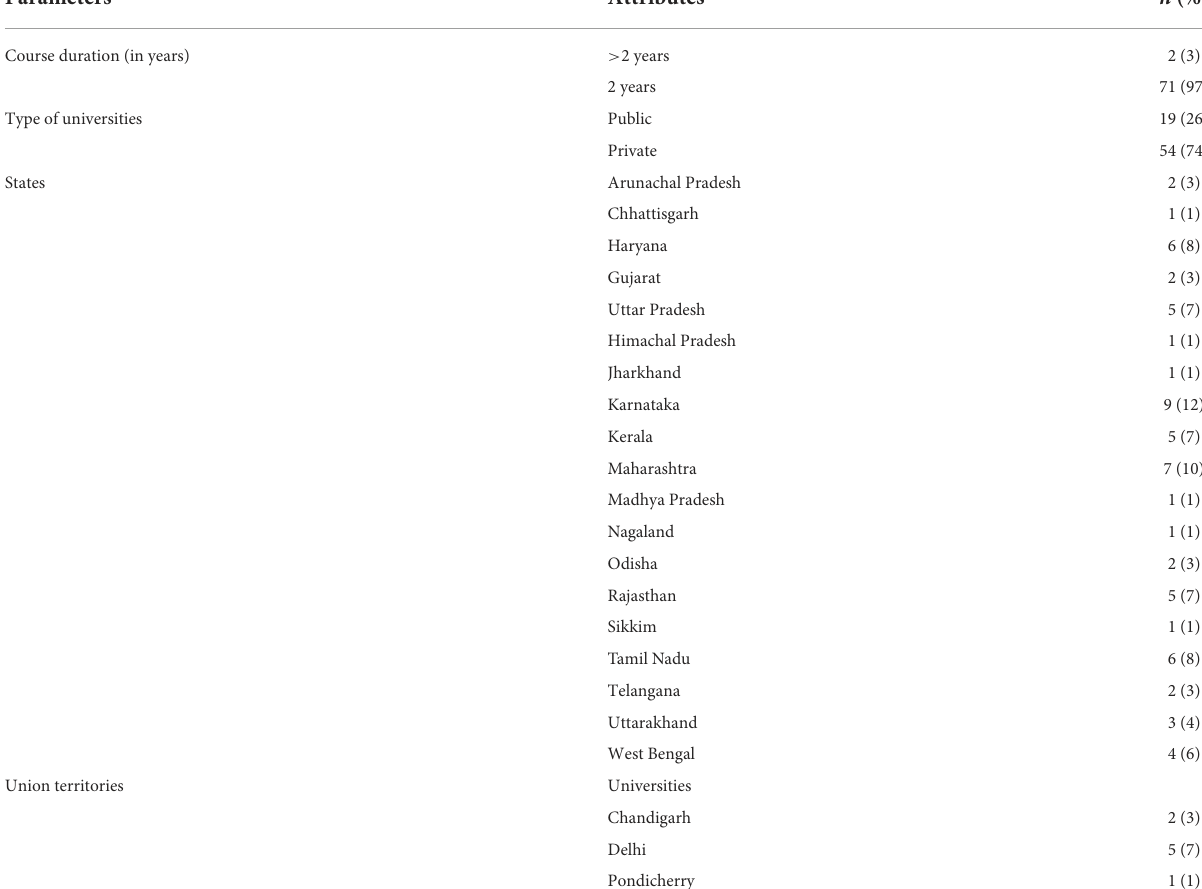
TABLE 4 MPH programs delivered by the different states/UTs of India ( N = 73). Parameters